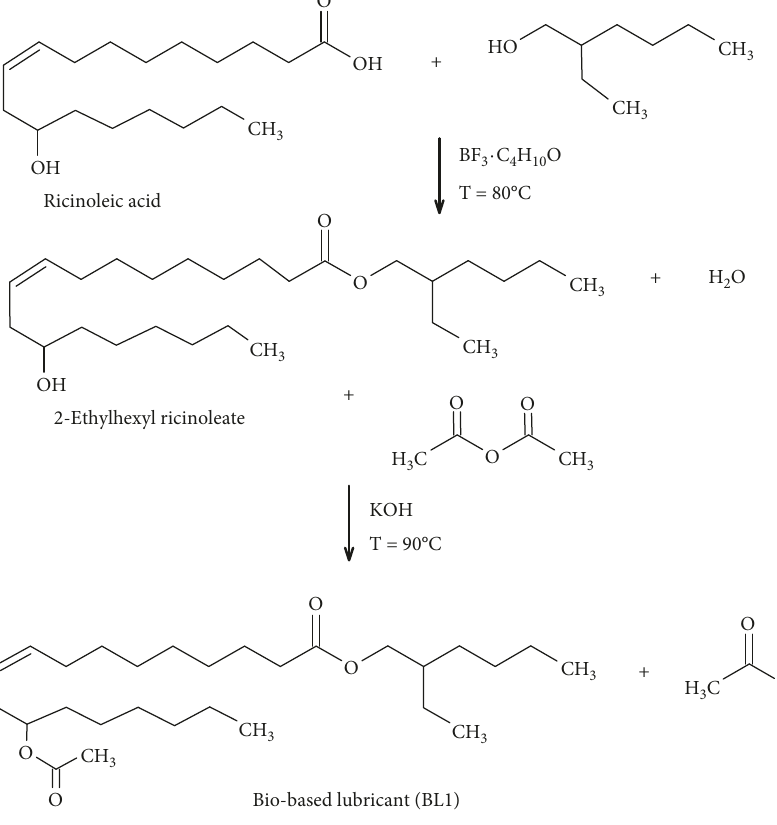
Figure 2: Synthetic route for the bio-based lubricant